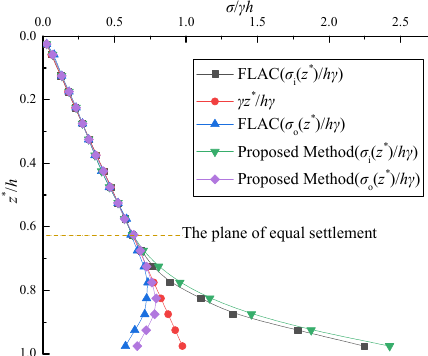
Figure 7. Vertical stress distribution of the inner cylinder and outer hollow cylinder in the embankment.